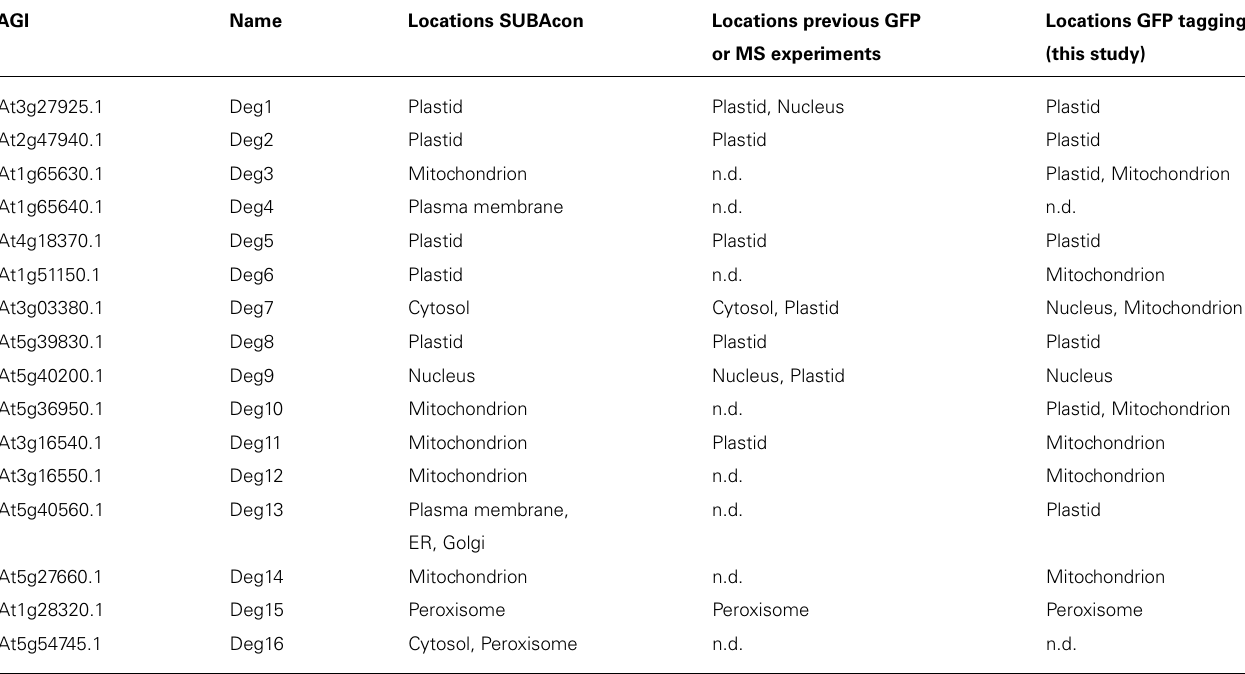
Table 2 | Overview of the subcellular locations of Deg proteases in Arabidopsis .